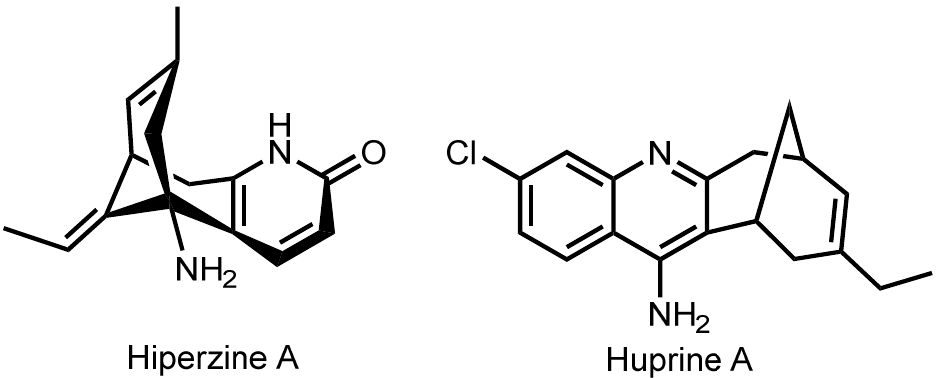
Figure 9. Huperzine A and THA–huperzine analogue Huprine A. 241 – 249 retained the high potency of the parent huprine Y against hAChE and